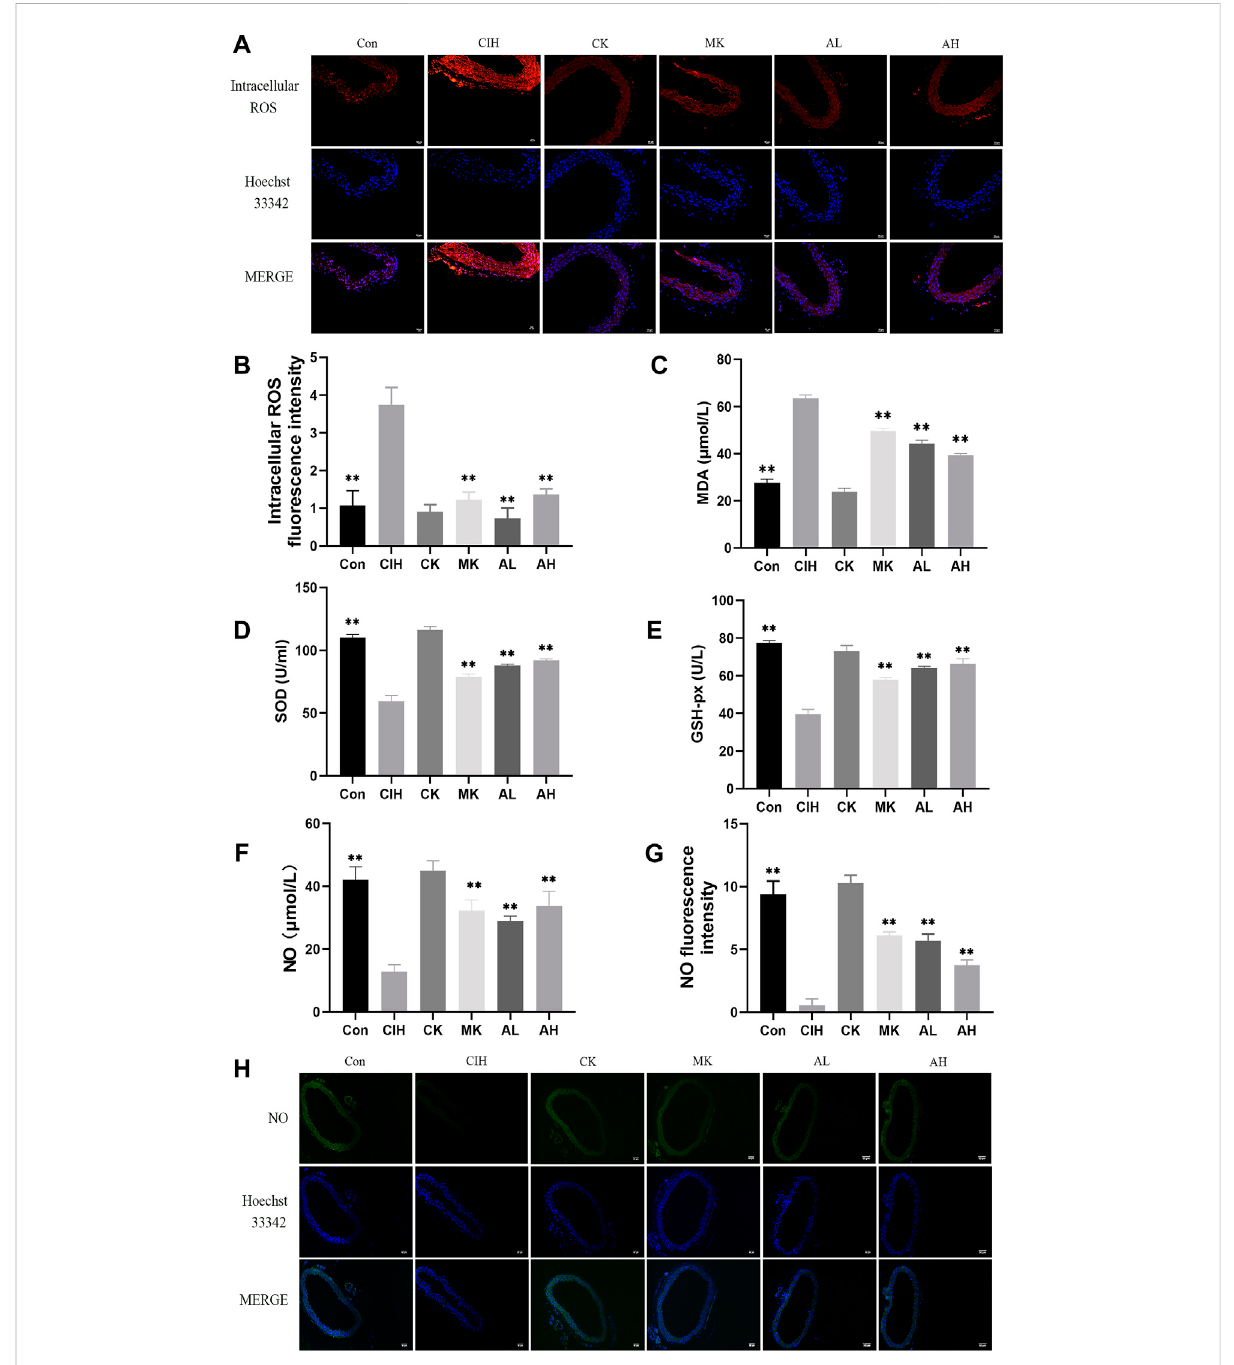
FIGURE 2 EffectsofAs-IV andCapn1knockoutonCIH-inducedoxidative stressandNOlevels. (A,B) ThelevelofintracellularROSinaortaswasmeasured usingDHEstaining(×200magni fi cation; n =3).DHEdye(red),Hoechst33342(blue). (C – E) The activityofSOD andthelevelsofMDAand GSH-pxin serumweredeterminedusingkits( n =8). (F) NOproductioninserumwasevaluatedusingthenitratereductasemethod( n =8). (G,H) ThelevelofNO in aortas was measured using DAF-FM DA fl uorescence staining (×100 magni fi cation; n = 3). DAF-FM DA dye (green), Hoechst 33342 (blue). Data are presented as means ± SD. ns. ** p < 0.01, vs. CIH